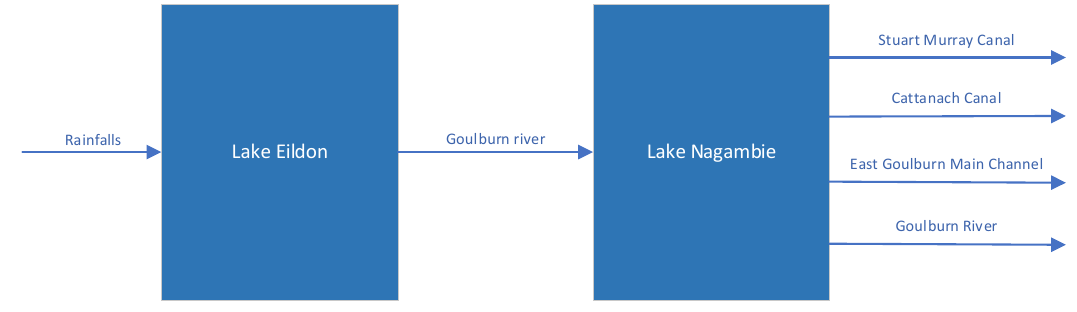
Figure 1. Goulburn River cascade